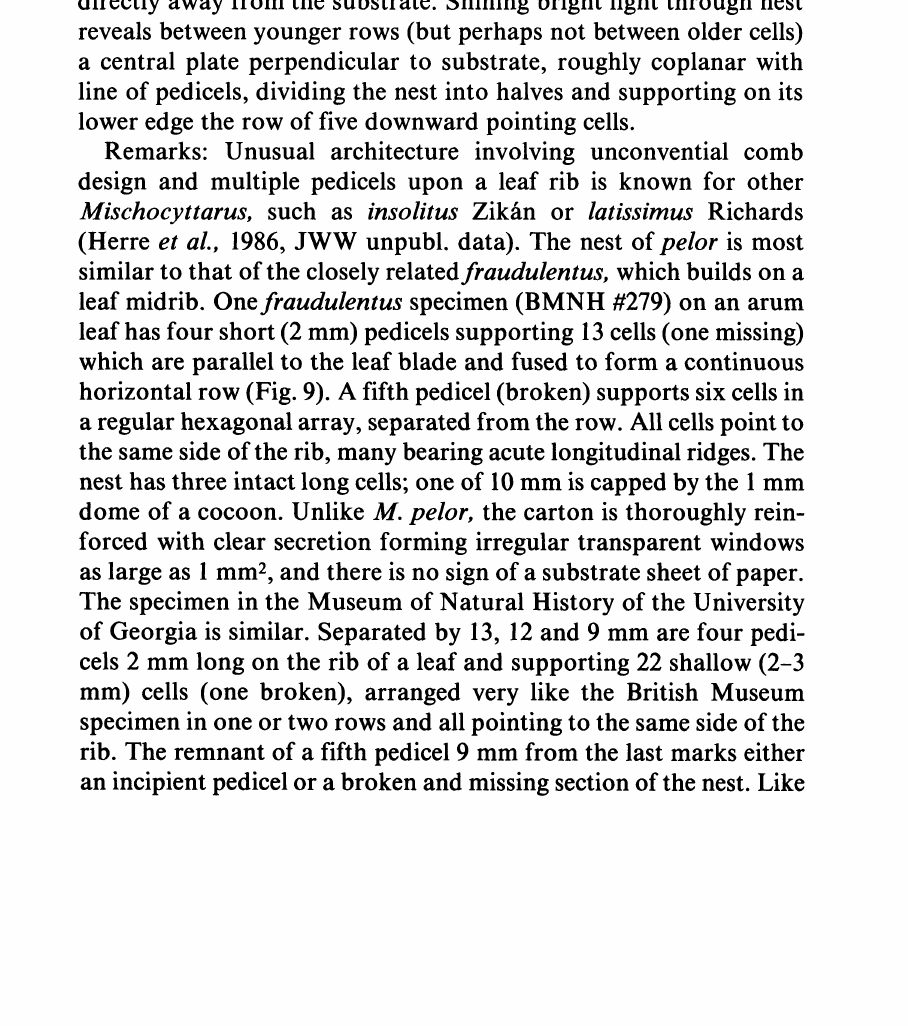
Fig. 7. Hypothetical cross-section through an expanding nest, edge view, per- pendicular to row of pedicels. 7a: LB leaf blade, P pedicel, S primary side of comb. 7b: $2 secondary side of comb, CP central plate axis, with central row of downward cells. 7c: SS substrate